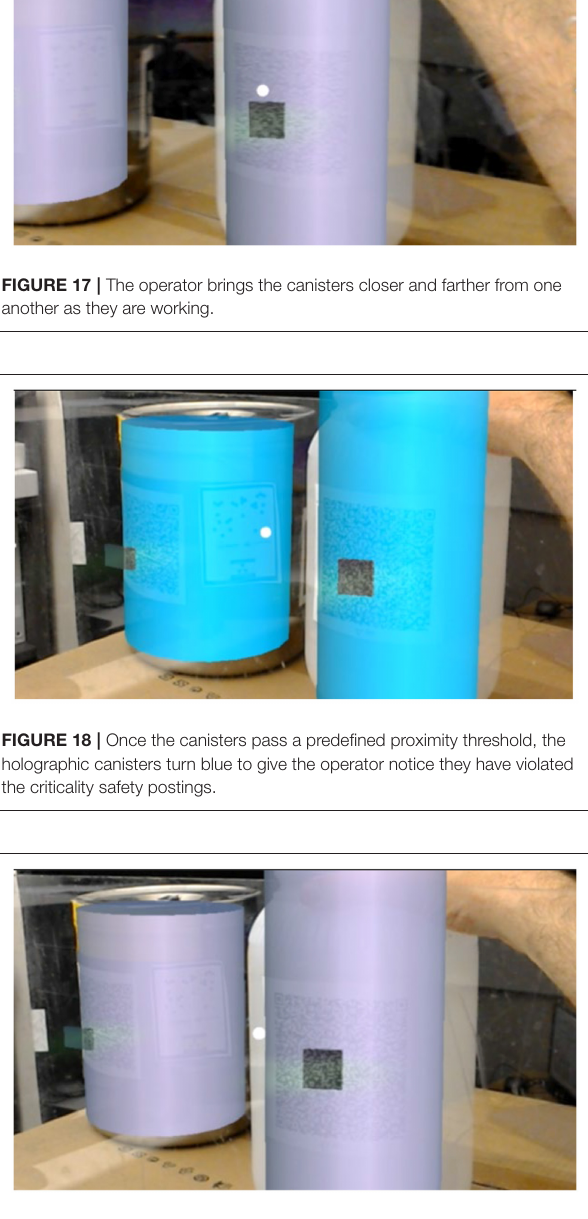
FIGURE 19 | Once the canisters are separated beyond the proximity threshold the color of the holographic canister returns to